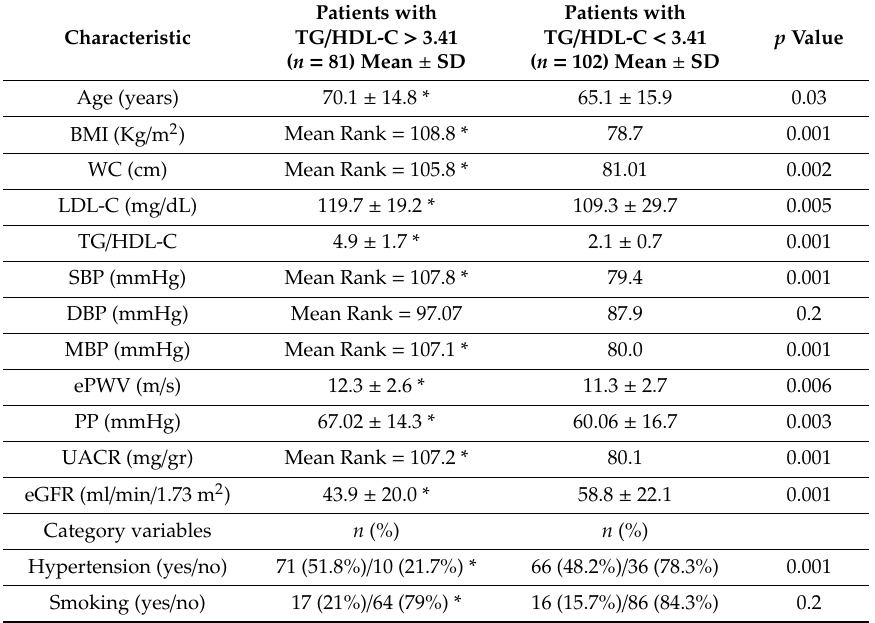
Table 3. The di ff erences between groups of patients according to the TG / HDL-C ratio cut-o ff point, either with an eGFR of less or more than 60 mL / min / 1.73 m 2 , equal to